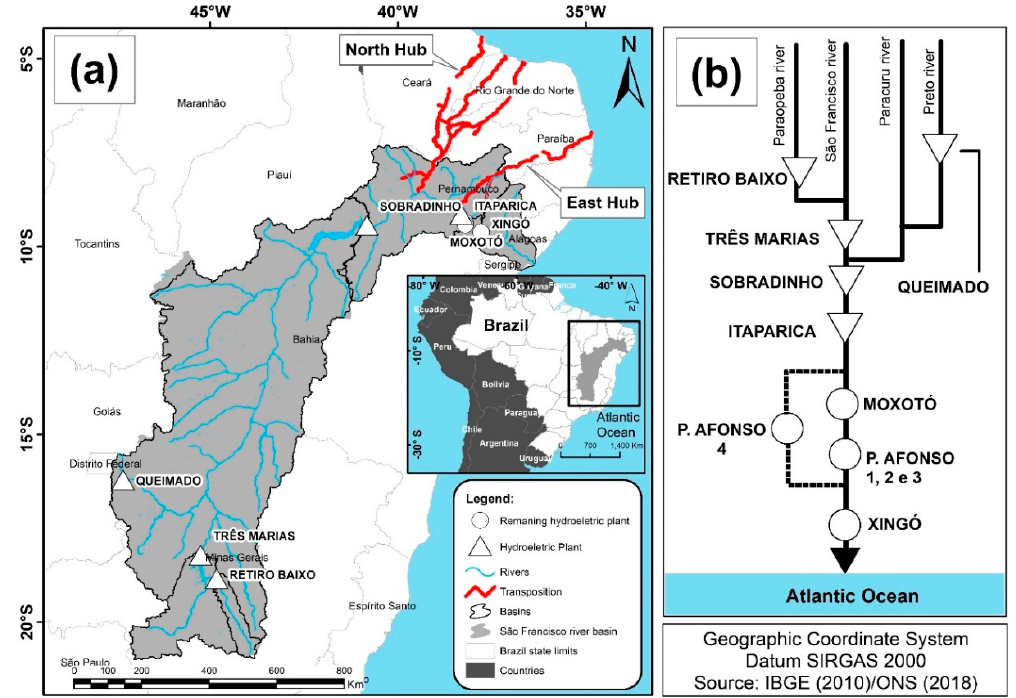
Figure 2. Location of Reservoirs, the water transfer canals in the Northeast Brazil Region (NBR) in ( a ), and schematic diagram of the hydroelectric power plant (HPP) belonging to the ( b ).